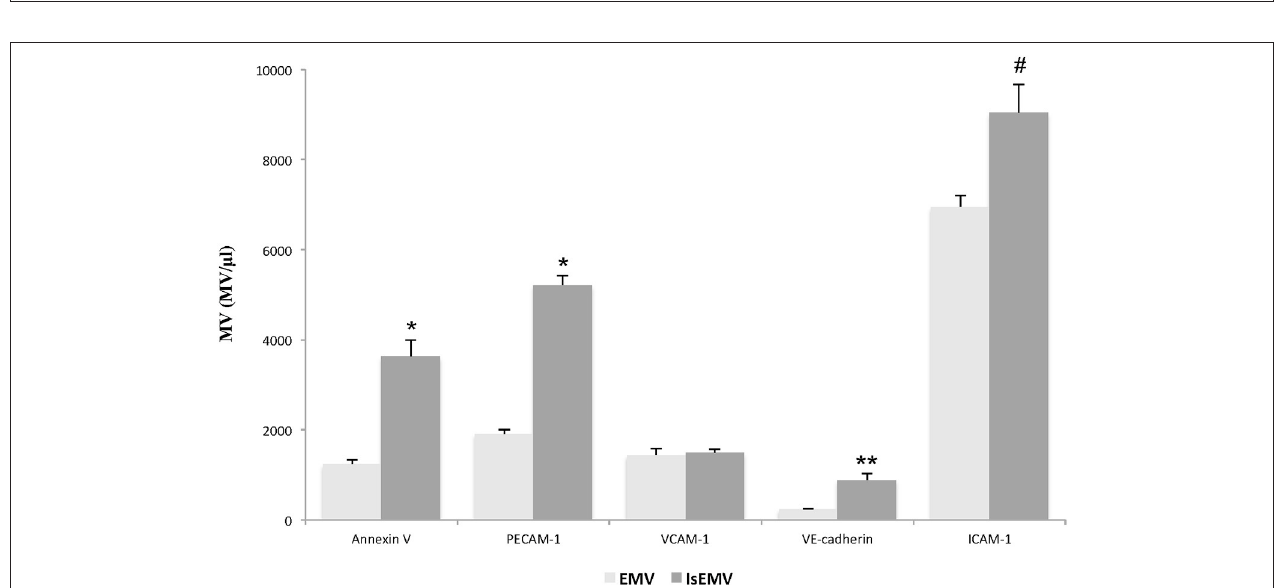
FIGURE 3 | Indoxyl sulfate (IS) modulates the expression of adhesion molecules and annexin V in microvesicles (MV). MV (MV/ µ l) derived from indoxyl sulfate-treated HUVECs (IsEMV) showed a significant increase in annexin V and adhesion molecules, such as PECAM-1, VE-cadherin, and ICAM-1, but not VCAM-1. Results are the mean ± SEM of five independent experiments. * p < 0.001 vs. MV derived from untreated HUVECs (EMV); ** p = 0.002 vs. EMV and # p = 0.014 vs.